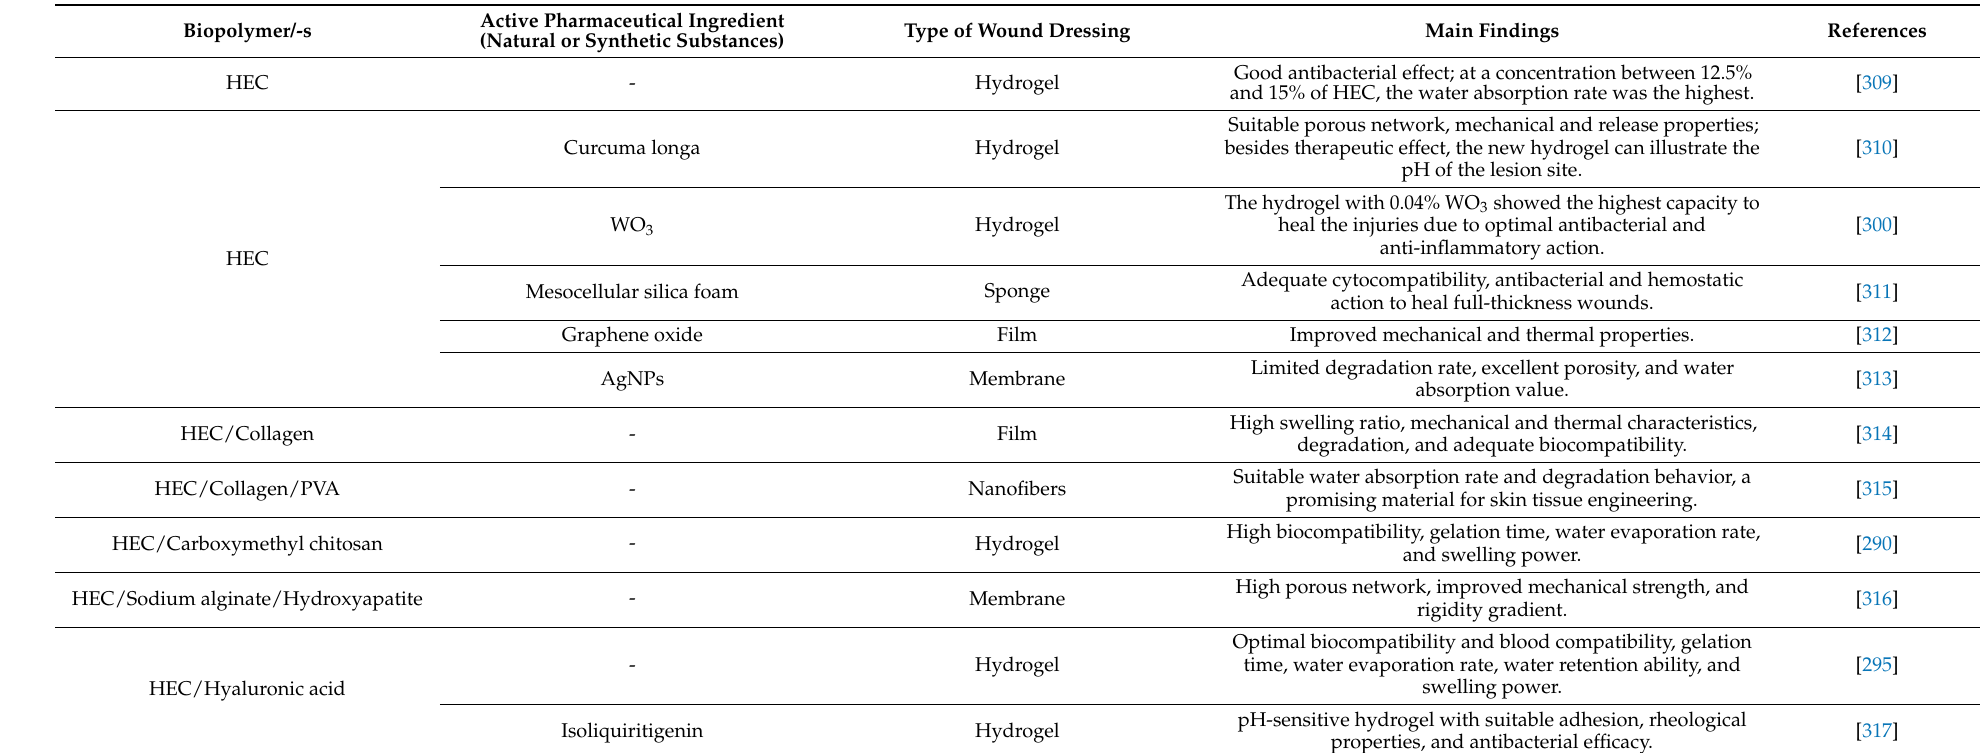
Table 6. Recent studies on the use of hydroxyethylcellulose as a wound